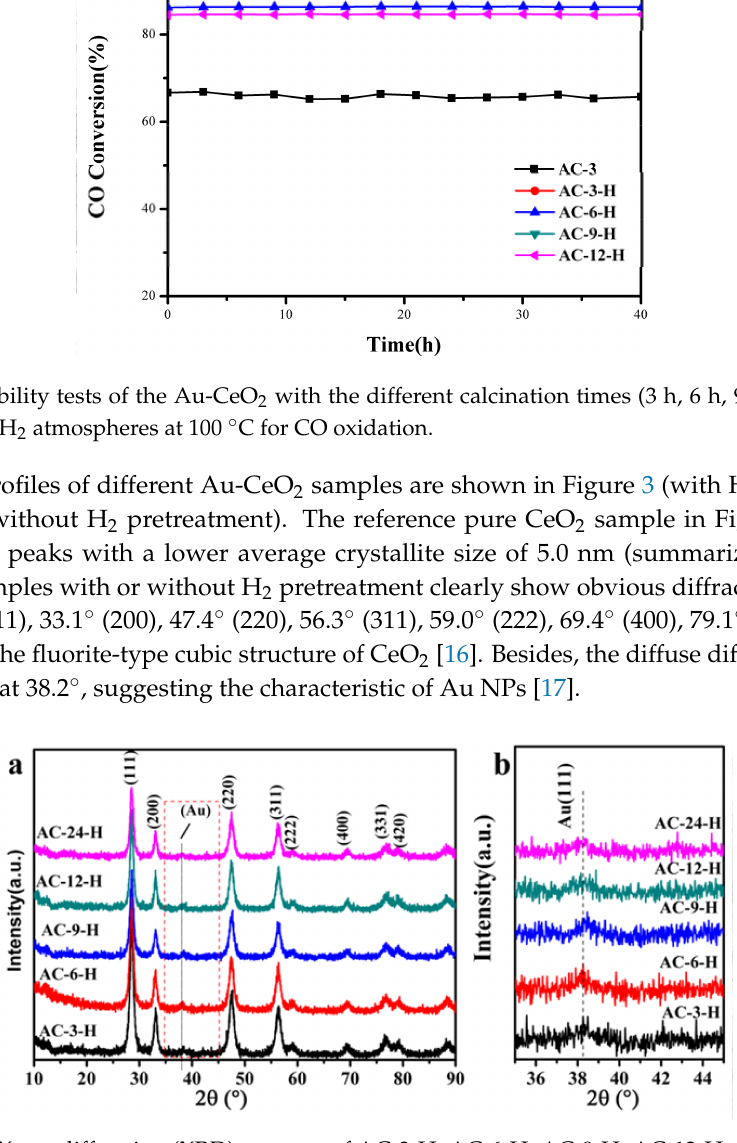
Figure 3. ( a ) X-ray diffraction (XRD) patterns of AC-3-H, AC-6-H, AC-9-H, AC-12-H and AC-24-H samples; ( b ) the enlargement of the box in ( a